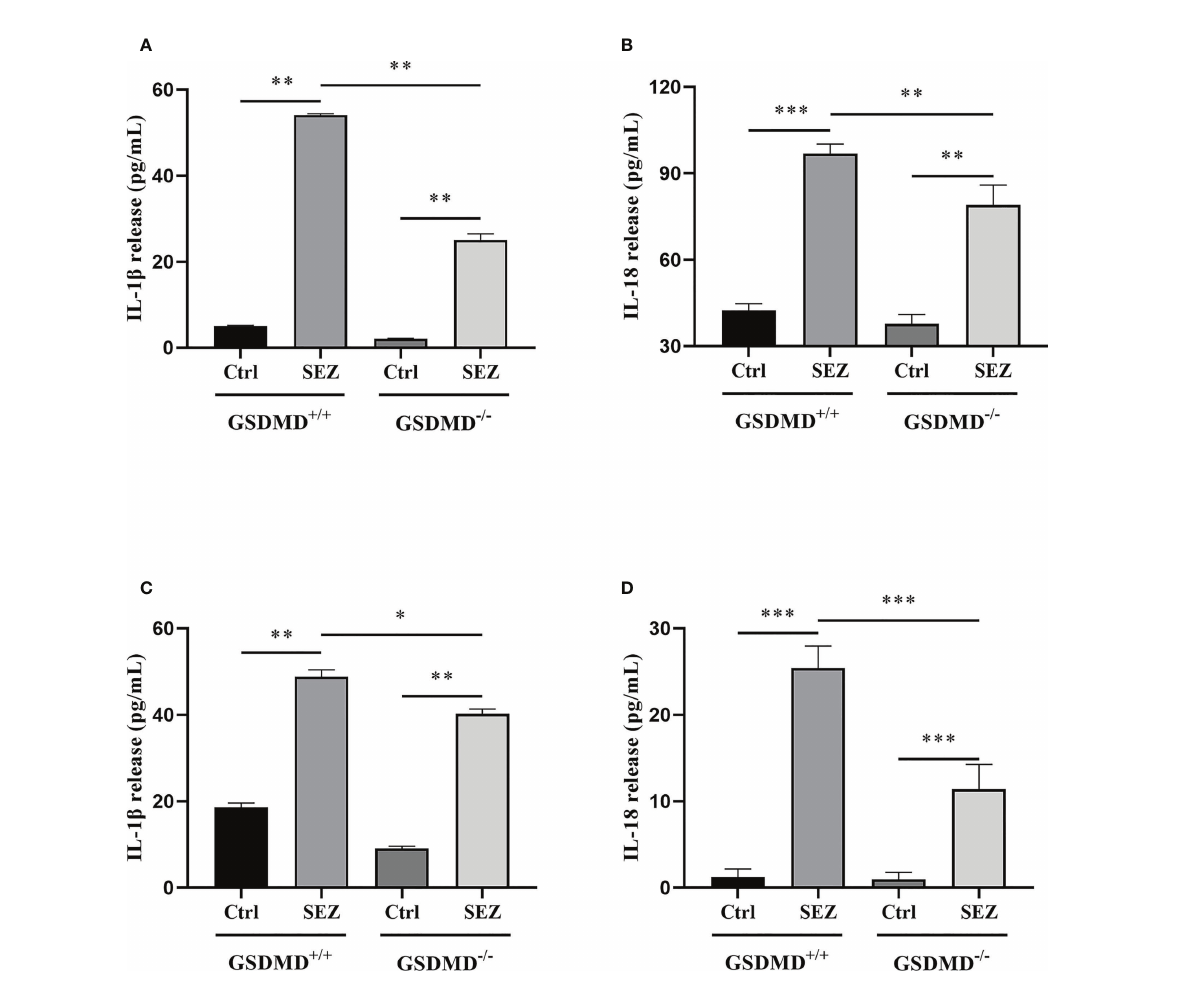
FIGURE 4 GSDMD de fi ciency signi fi cantly reduces IL-1 b and IL-18 release during SEZ infection. (A) IL-1 b and (B) IL-18 secretion in PLF of mice (n=3) were measured at 24 h post-infection (10 6 CFU) or non-infection (equivalent PBS), and (C) IL-1 b and (D) IL-18 release were determined in the macrophage supernatants with or without SEZ (MOI=10) treatment for 12 h. These experiments were conducted with 3 replicates. Data are expressed as mean ± SD. * p <0.05, ** p <0.01, *** p <0.001, one-way